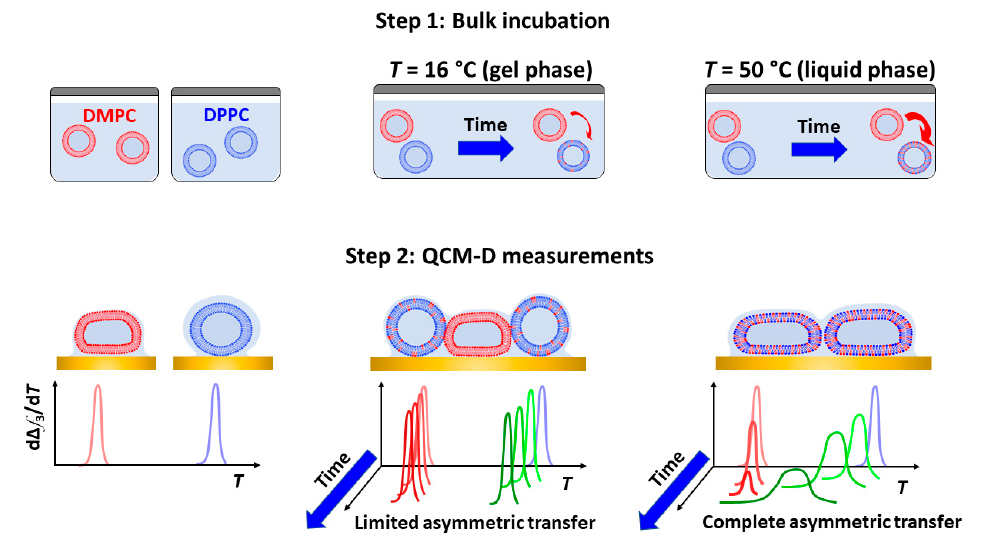
Figure 6. Schematic representation of lipid transfer detected by QCM-D nanoviscosity measurements.